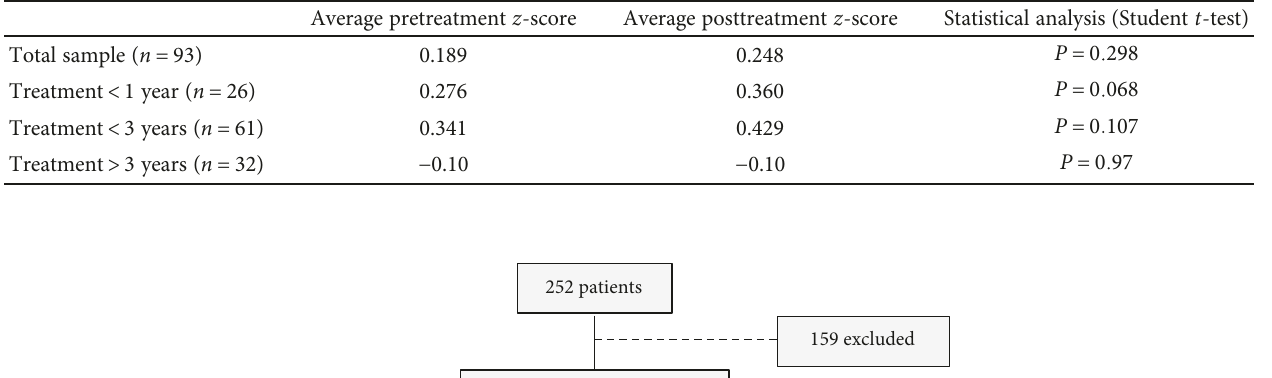
Table 3: Comparison between pre- and posttreatment height z -scores.